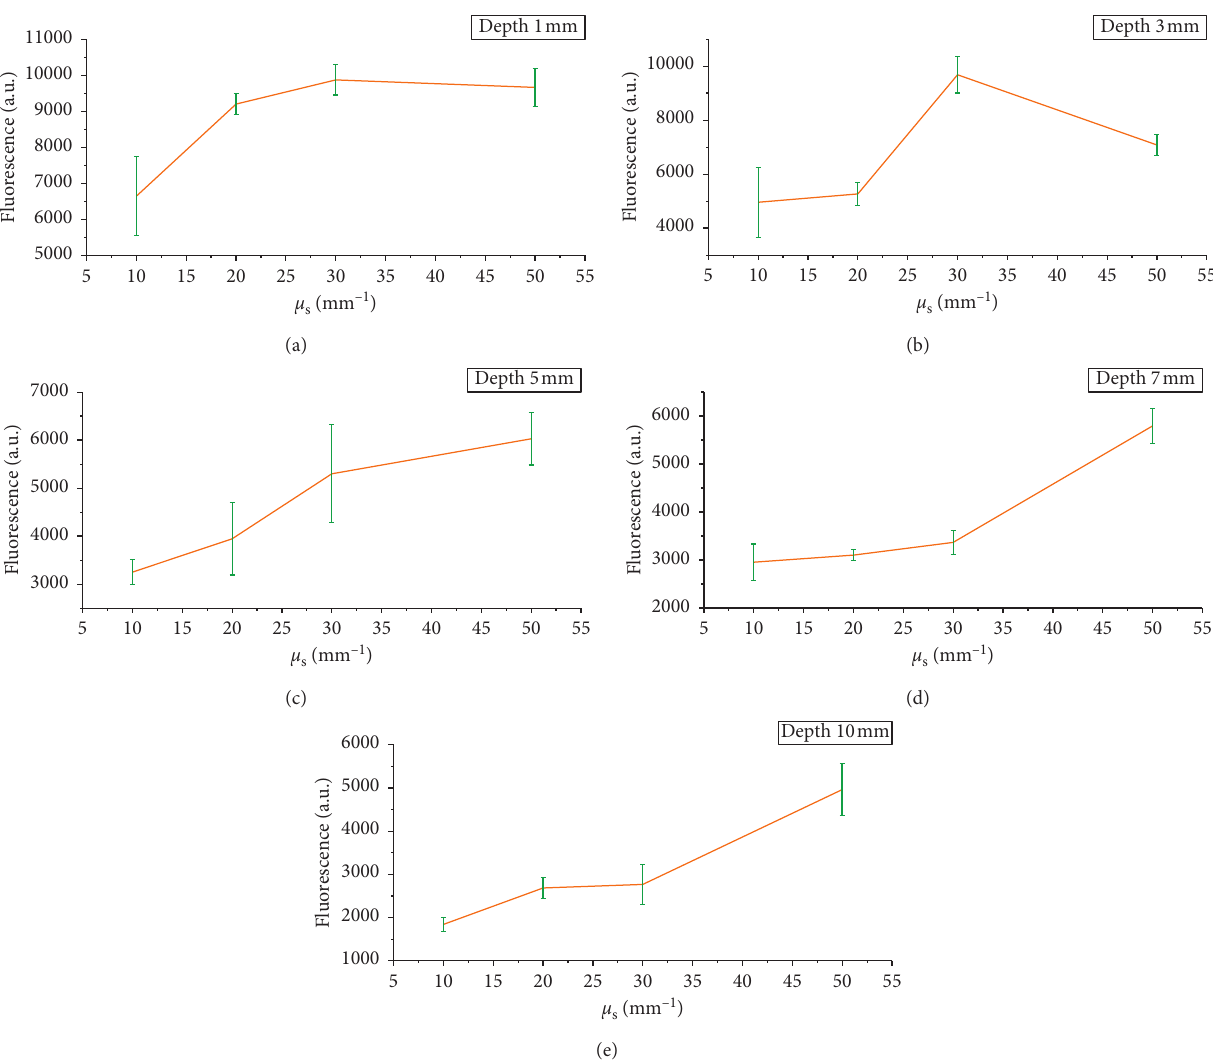
Figure 5: (a–e) Mean values and standard deviations of fluorescence intensity at 635nm as a function of scattering coefficient for different